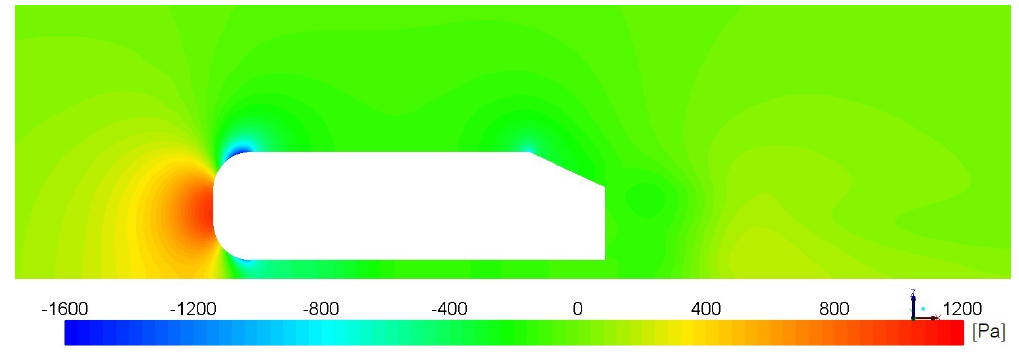
Figure 4. Pressure distribution around the Ahmed body at symmetry